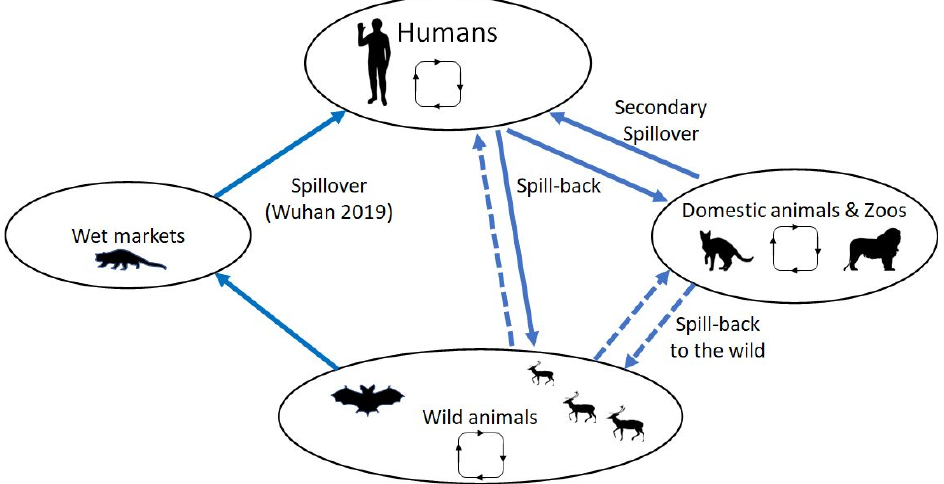
Figure 1. Schematic diagram for the known and inferred transmission pathways for SARS-CoV-2. The virus originated in the wild, probably in bats, and initial spillover/amplification happened at the Wuhan Seafood wet market. Entering the human population, the virus caused the COVID-19 pandemic. The resulting circulation led to the evolution of many new variants. Spillback into domestic and zoo animals was observed beginning in 2020, notably with mink in Denmark, where circulation in the farm populations led to new strains. Direct spillback from humans into wild animals has been observed, also followed by circulation and evolution of new strains. Secondary spillover from the wild into domestic animals or humans and/or spillback into the wild from captive animals are denoted by broken lines (animal silhouettes were obtained from Wikimedia